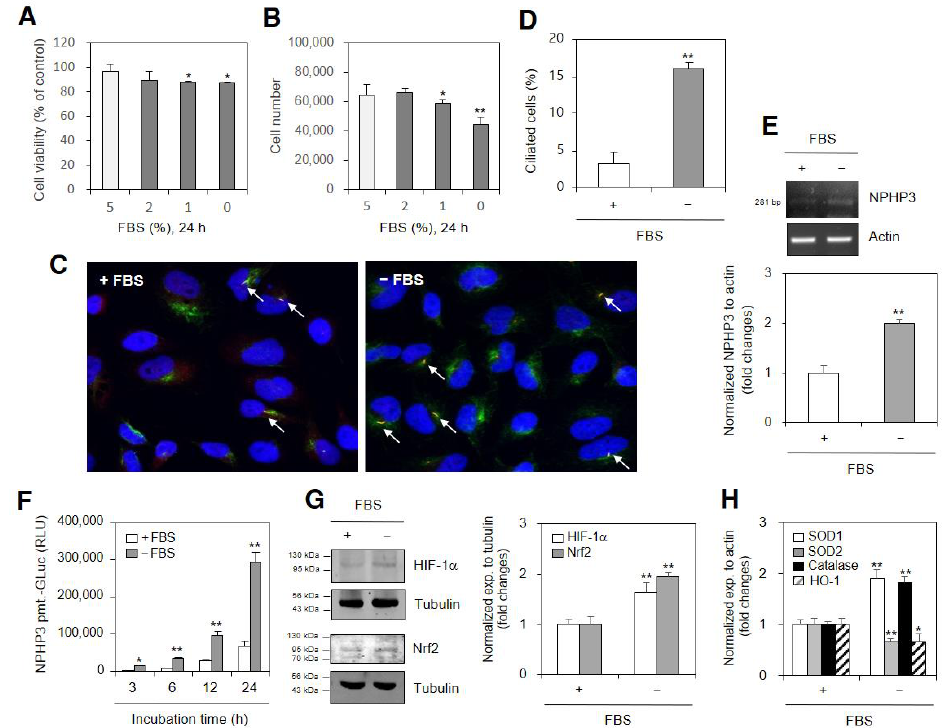
Figure 1. Changes in cell viability and cell number were associated with primary cilium formation, NPHP3 expression and HIF-1 α stabilization under serum-deprived (SD) condition. ( A – E ) HeLa cells were incubated in a medium with various percentages of fetal bovine serum (FBS) for 24 h. Cell viability was measured by the trypan exclusion assay ( A ). Cell number was counted by using hemocytometer ( B ). The cells were fixed and stained with antibodies against Ac-tubulin (green) and Arl13b (red). Nucleus was stained with DAPI (blue). The primary cilium was observed with 1000 × magnification under fluorescence microscope. The image with primary cilia is the representative out of ≈ 30 pictures. White arrows indicated primary cilia ( C ). The ciliated HeLa cells ( n > 500 cells) in the presence (white) or absence (grey) of FBS were counted ( D ). Total RNA was prepared by using NucleoZOL ® and the expression level of NPHP3 was measured by RT-PCR ( E top). Density of each band was analyzed by ImageJ 1.34 n and results were normalized to actin ( E bottom). ( F ) HeLa cells were transfected with pEZX-PG02-NPHP3-promoter Gaussia luciferase (Gluc) plasmids and incubated in the presence or the absence of FBS for up to 24 h. The activity of Gluc in cultured media was measured with luminometer using Gluc substrate. ( G – H ) HeLa cells were incubated with or without FBS for 24 h. Cell lysates were prepared. HIF-1 α and Nrf2 proteins were detected by Western blot analysis (left). Density of each band was analyzed by ImageJ 1.34 n and results were normalized to tubulin (right). Total RNA was prepared by using NucleoZOL ® and the expression level of each antioxidant gene was measured by Q-PCR ( H ). Data were the representative of four experiments. Processing (such as changing brightness and contrast) is applied equally to controls across the entire image ( C , E , G ). Data in bar graphs represents the means ± SEM. * p < 0.05, ** p < 0.01; significantly different from 5% FBS-treated control group ( A , B , D , E bottom, G right, H ) at each time point ( F